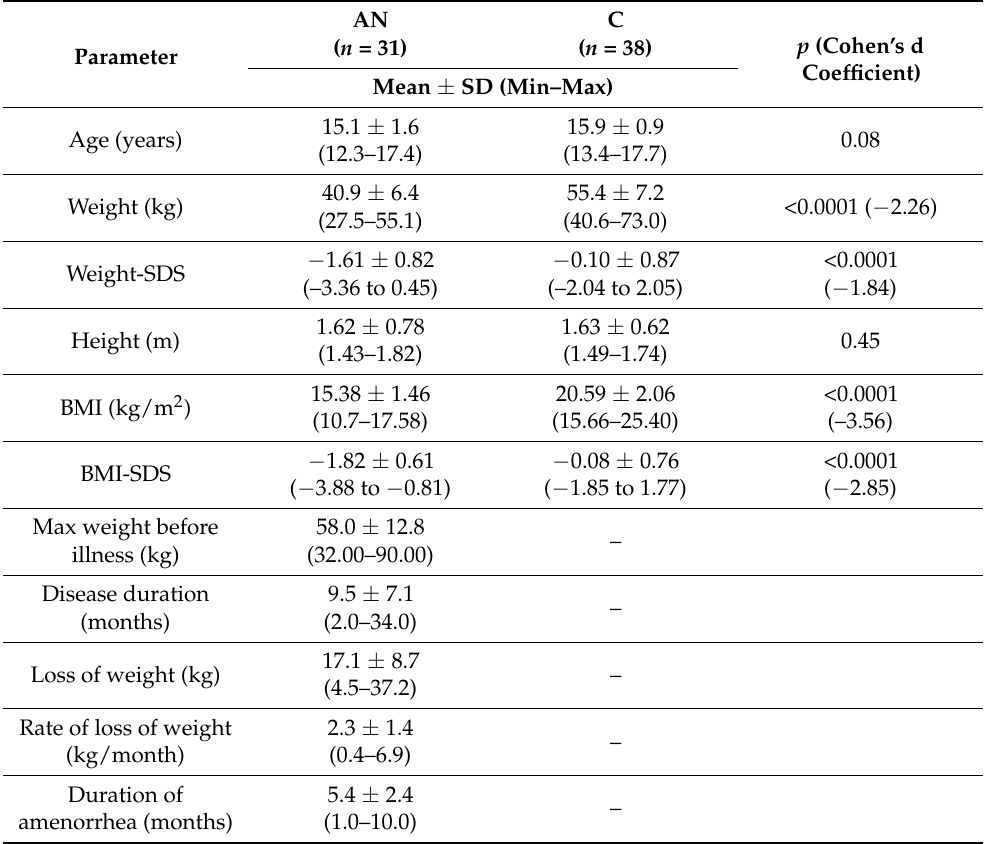
Table 1. Clinical characteristics of the studied group of girls with anorexia nervosa (AN) and the healthy control